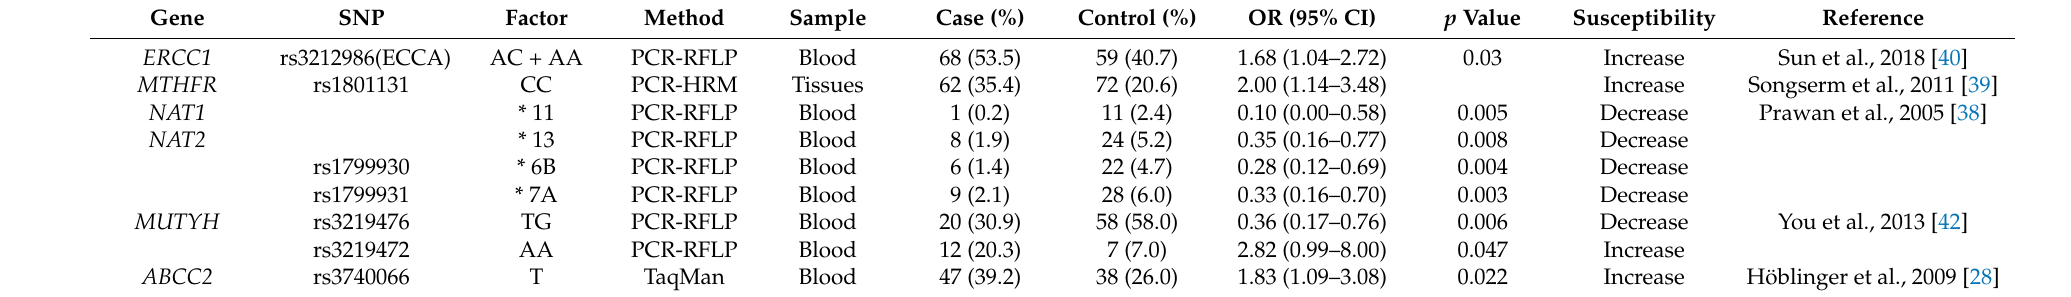
Table 3. The relationship between SNPs in DNA repair genes and cellular protection against toxin genes with the susceptibility of CCA. Various studies investigated the SNPs of DNA repair genes and cellular protection against toxin genes related to the susceptibility of CCA. NAT2 *6B, 590G > A (rs1799930); NAT2 *7A, 857G > A (rs1799931); NAT1 *11 and NAT2